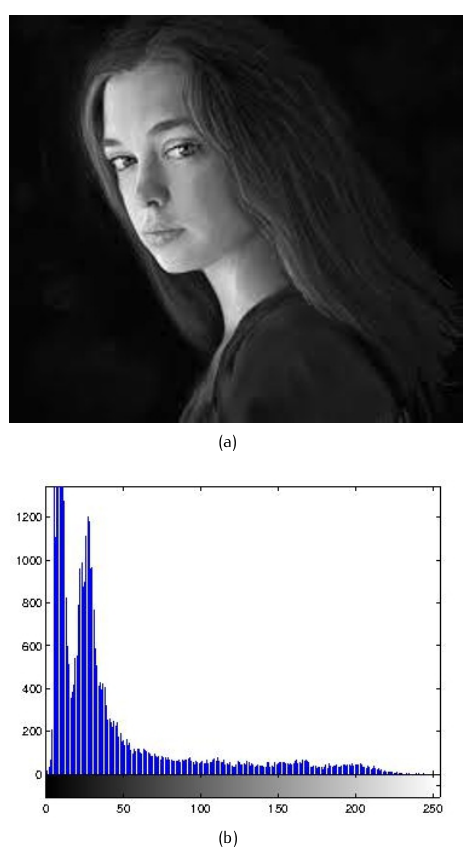
Figure 1. A sample low-key image and its histogram. (a) A typical low-key image. (b) The histogram of (a).